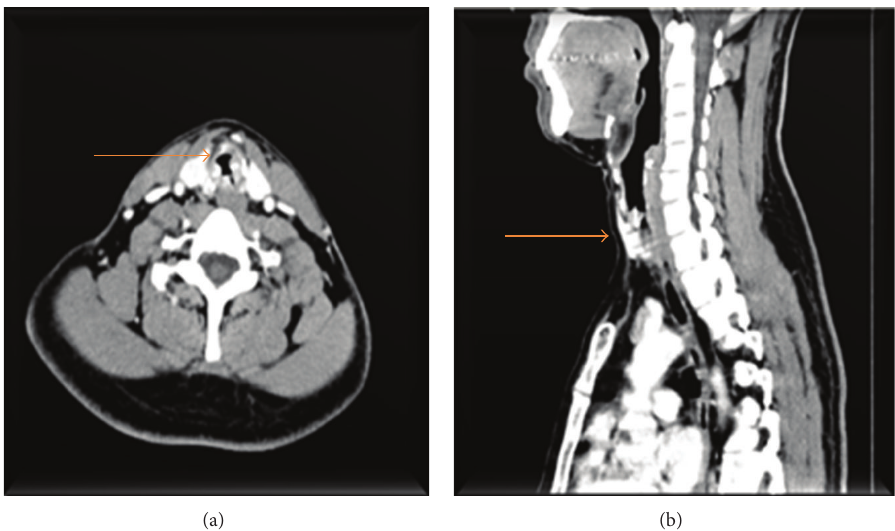
Figure 2: Circumferential thickening in the subglottic region.